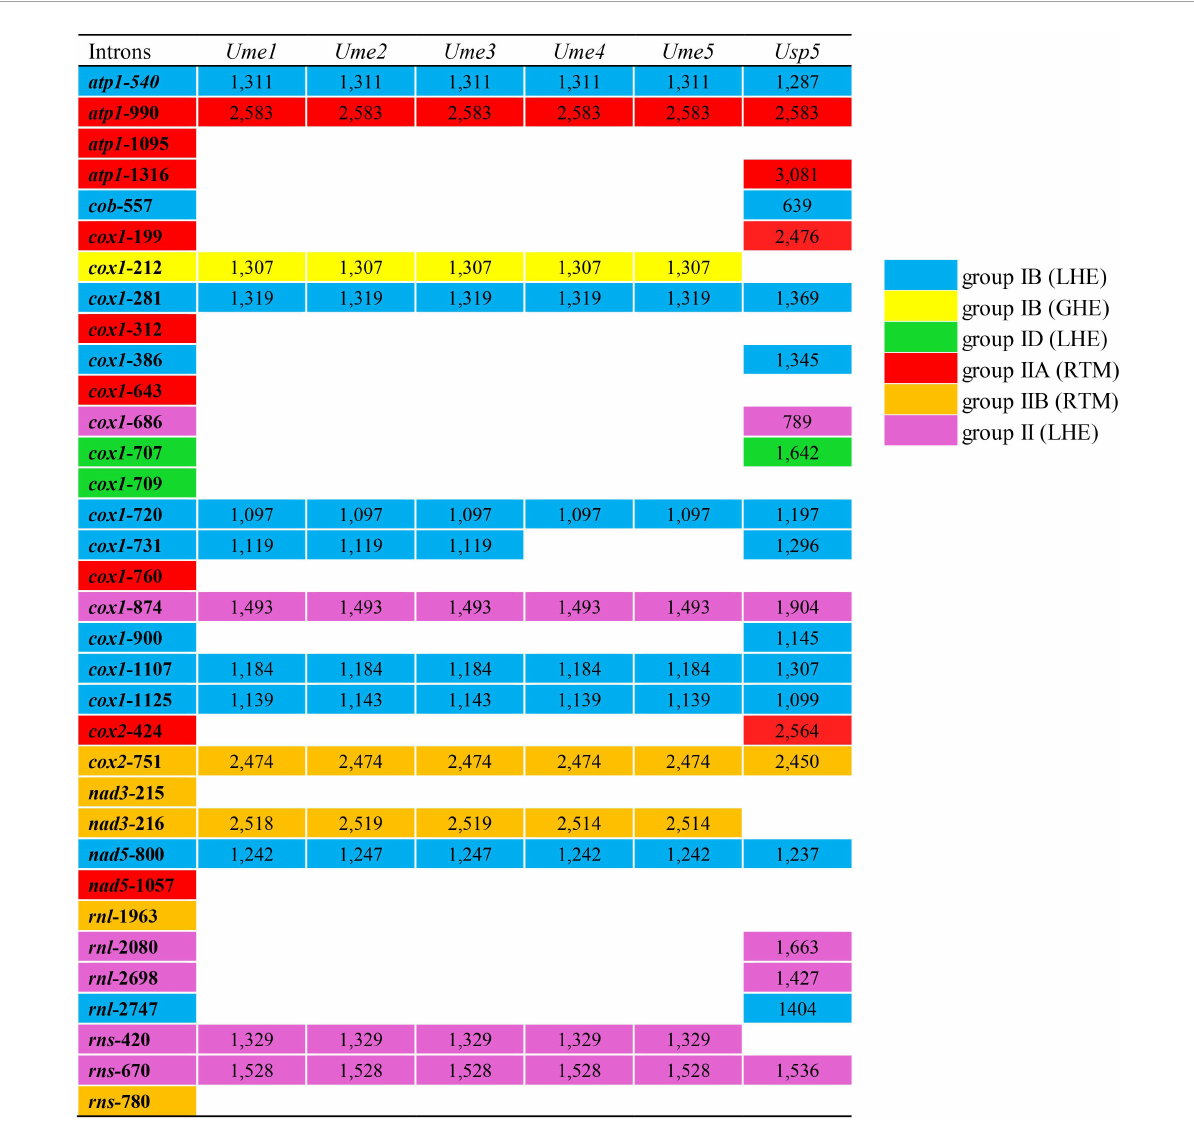
FIGURE2 Insertion site, size and group of introns detected in five mitogenomes of Ulva meridionalis ( Ume1 – Ume5 ), as well as the mtDNA of Ulva sp. (MN853878) ( Usp5 ) for comparative analysis. Ulva prolifera (MN853878) deposited in the GenBank database was corrected to Ulva sp. (MN853878), due to its wrong species name assignment. Intron name was defined as host gene plus insertion site which was determined by comparing homologous genes relative to the mitogenome of U. compressa (KY626327) (Liu F. et al., 2022). All insertion sites previously detected in the sequenced Ulva mitogenomes were listed in the first column. The intron cox1 -214 is corrected to intron cox1